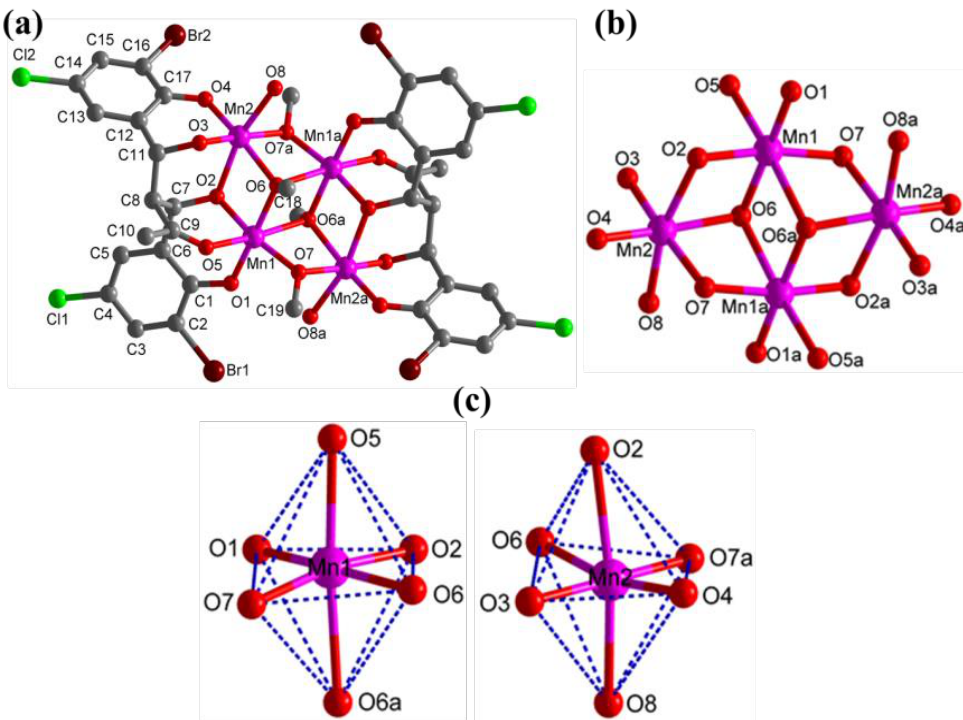
Figure 3. ( a ) Molecule structure and atom numbering of complex 2 (hydrogen atoms are omitted for clarity); ( b ) the planar Mn 4 rhombus and ( c ) the coordination polyhedra for Mn III atoms of complex 2 (symmetry code: a = 1 − x, 1 − y, 1 − z).